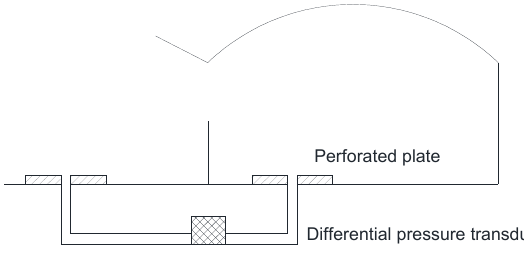
Figure 10. The setup of the experiments measuring the pressure difference between the inside and outside of a greenhouse, adapted from Boulard et al. [34].